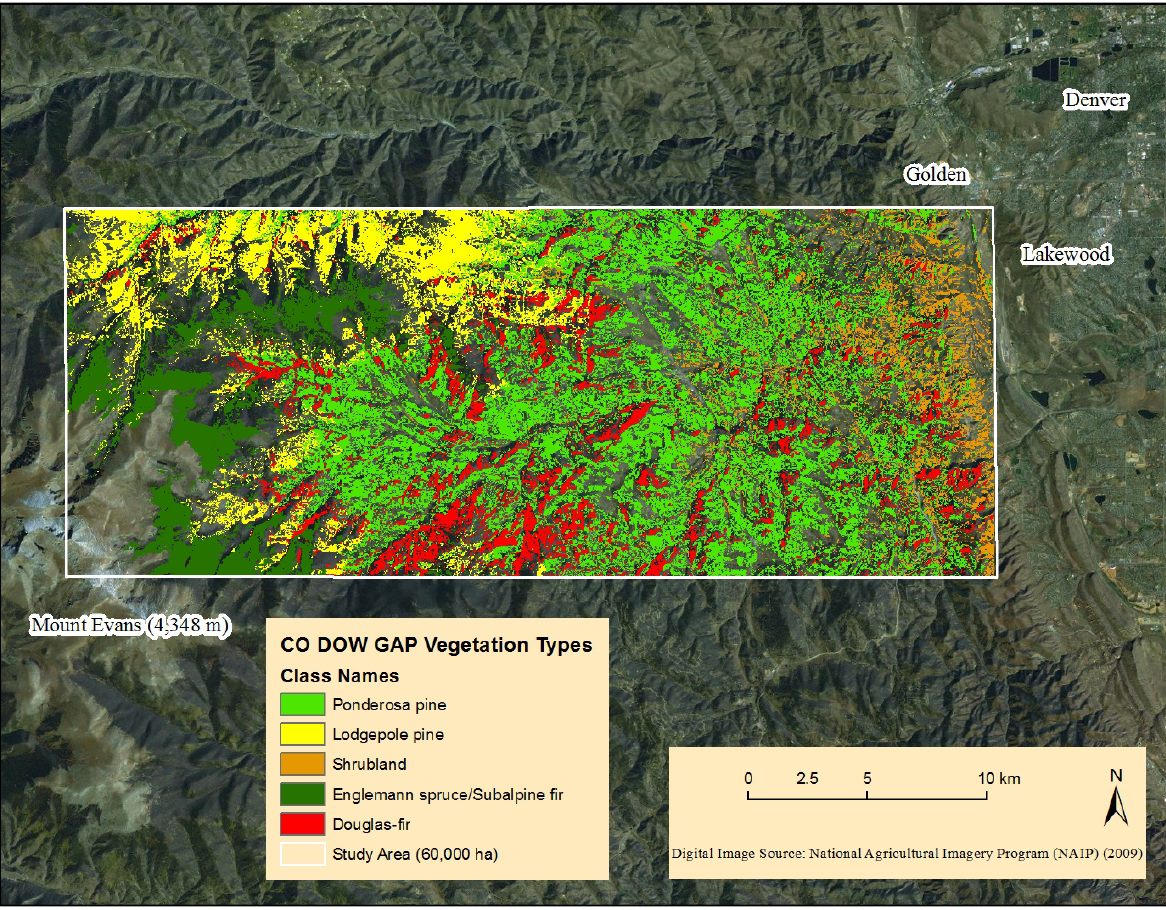
Figure 1. Location of the soil charcoal sampling area with current vegetation types west of Denver, CO in the Colorado Front Range. Geospatial data was acquired from United States Geological Service (USGS) GAP Analysis Project [23] and United States Farm Services Agency (FSA) National Agricultural Imagery Program